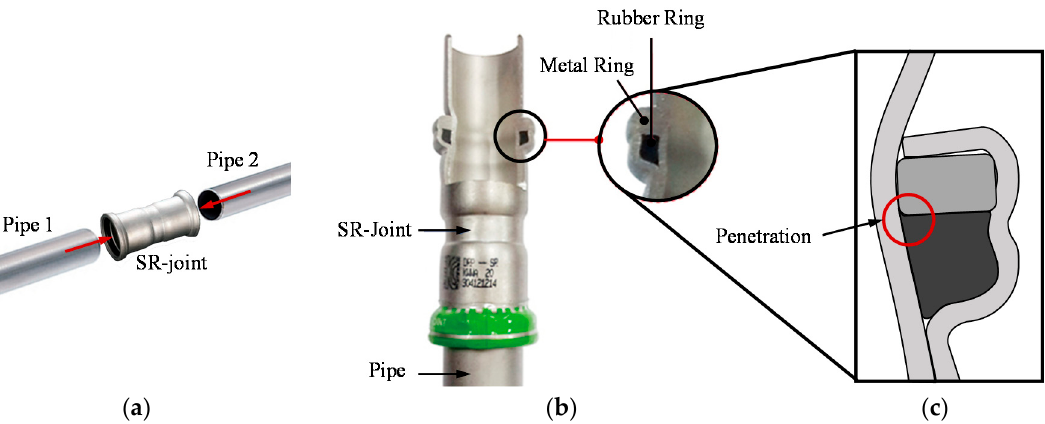
Figure 1. ( a ) Principle of stainless ring (SR) joint connection ( b ) Combined shape and cross-section of pipe and joint ( c ) An enlargement of the dual ring part.